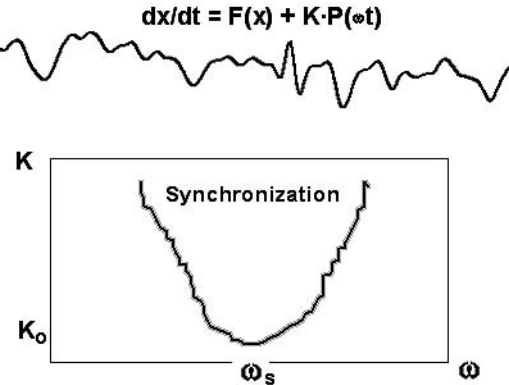
Fig. 18. Diagram illustrating the occurrence of the synchronization effects in a dynamic system containing chaotic and quasi-periodic components. The upper curve is an example of temporal variations in the vibration amplitude (see explanations in the text).